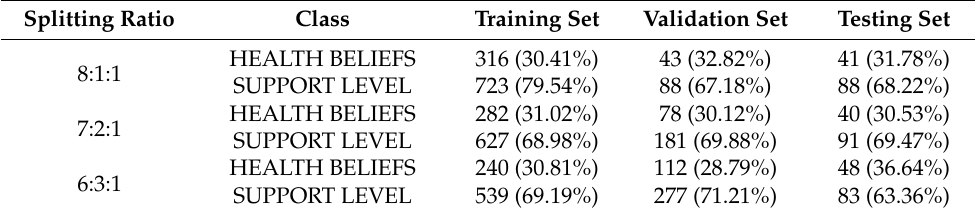
Table 4. The detailed data distribution of each category for training, validation, and testing.